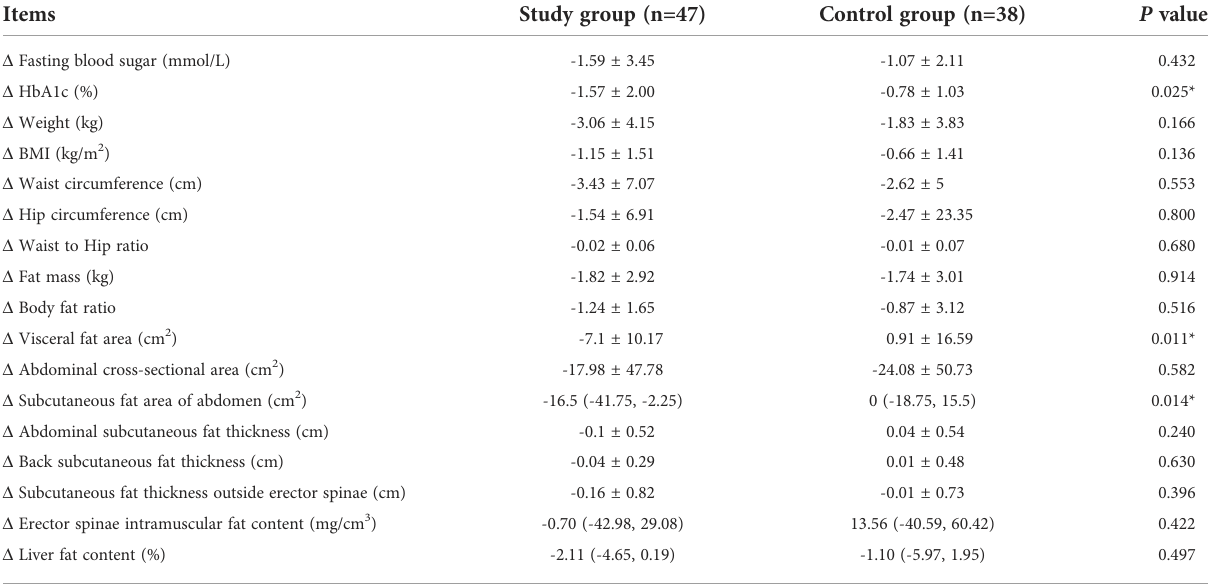
TABLE 3 Changes of blood sugar related indicators, physical measurements, and abdominal fat distribution. Items